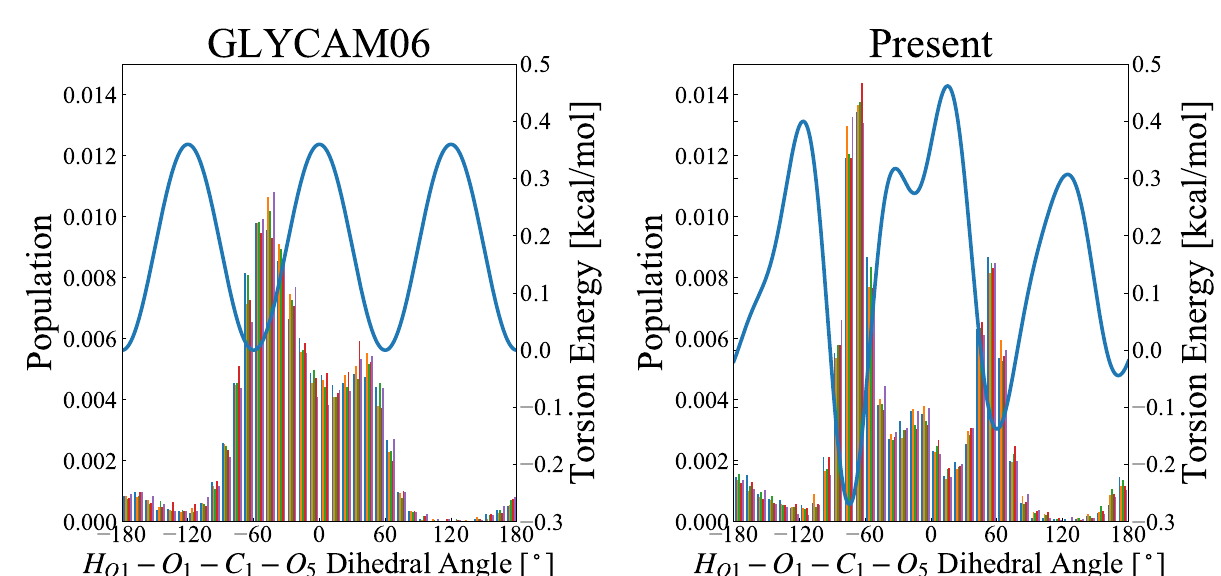
Figure 7. Distribution of H O 1 – O 1 – C 1 – O 6 rotamers, obtained in the MD simulations. The abscissa represents the dihedral angle, ranging from − 180 ◦ to 180 ◦ , and the ordinate is the probability density function calculated over 5000 snapshots. The left and right figures, respectively, show the results for the GLYCAM06 force field and our proposed force field as the molecular force fields for the MD simulations. The MD calculations were performed for 50-ns-long product runs in five replicates (represented by colors), and the rotamer distribution was calculated from each of the 5000 snapshots. The blue curve in each panel represents the potential energy for torsional motion ( H O 1 – O 1 – C 1 – O 6 ) associated with a change in the dihedral angle of H O 1 – O 1 – C 1 – O 6